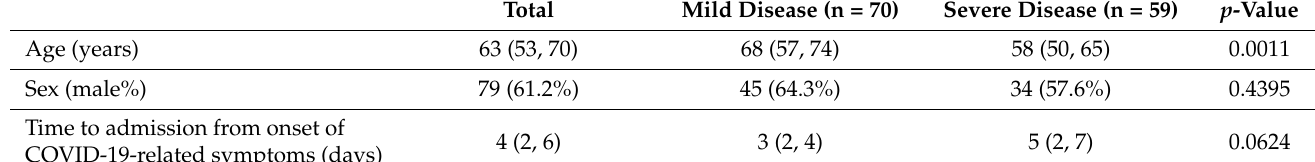
Table 1. Characteristics of the study